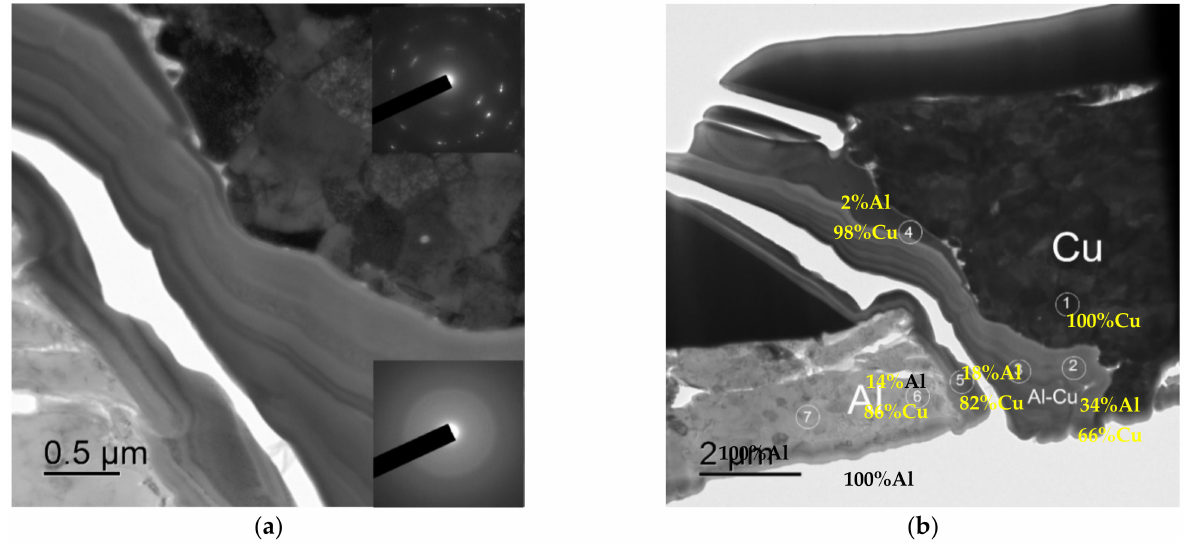
Figure 7. The results of the electron microscopy investigations of the interphase boundary in the bimetallic wire that were made from Alloy #3: ( a ) general view; ( b ) the results of the energy dispersion spectrometer (EDS) microanalysis (in wt.%).